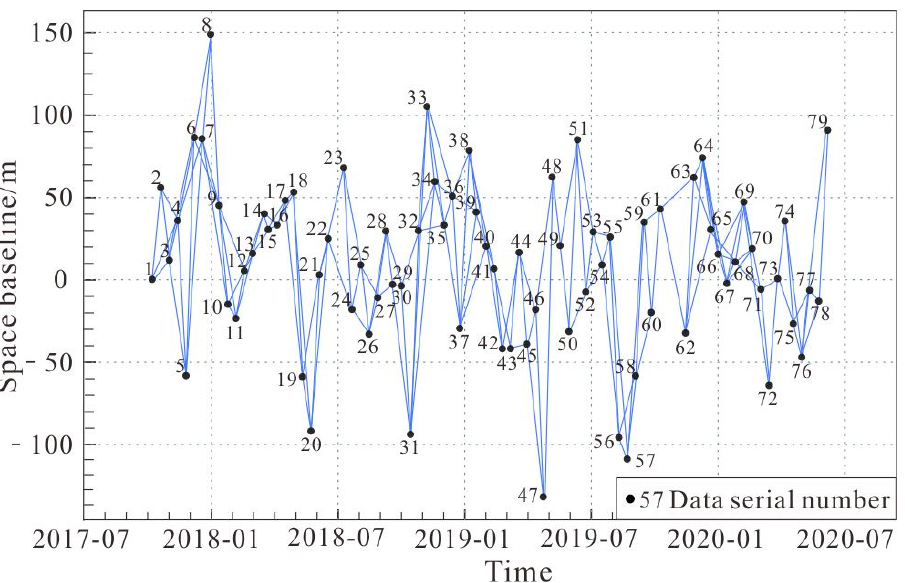
Figure 6. Spatiotemporal baseline map of SBAS-InSAR interferometric data of the Xiongba ancient landslide.